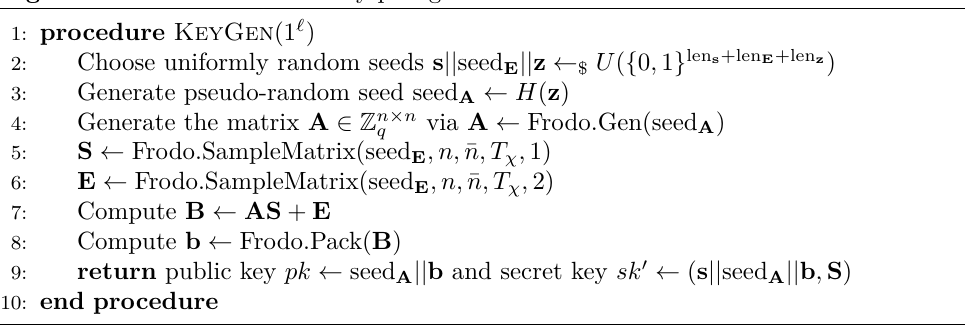
Algorithm 2 The FrodoKEM